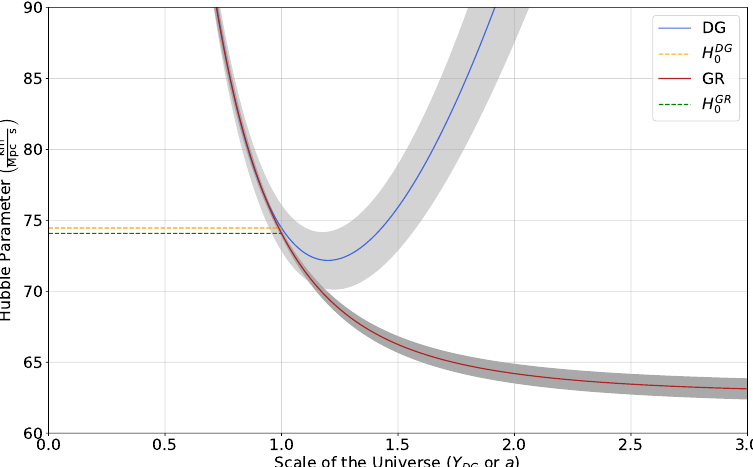
Figure 8. Hubble Parameter for Delta Gravity and GR fitted models assuming M V = −